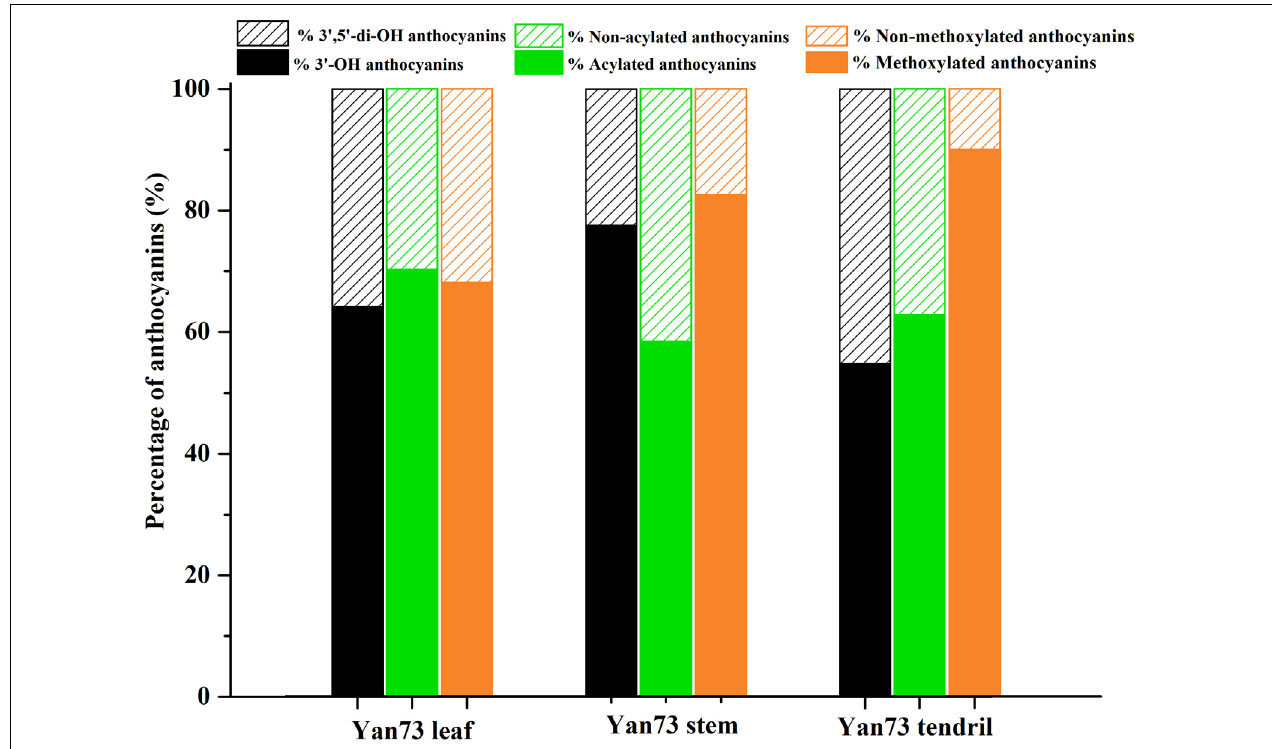
FIGURE 2 | Proportions of different kinds of anthocyanins in Yan73 leaf, stem, and tendril